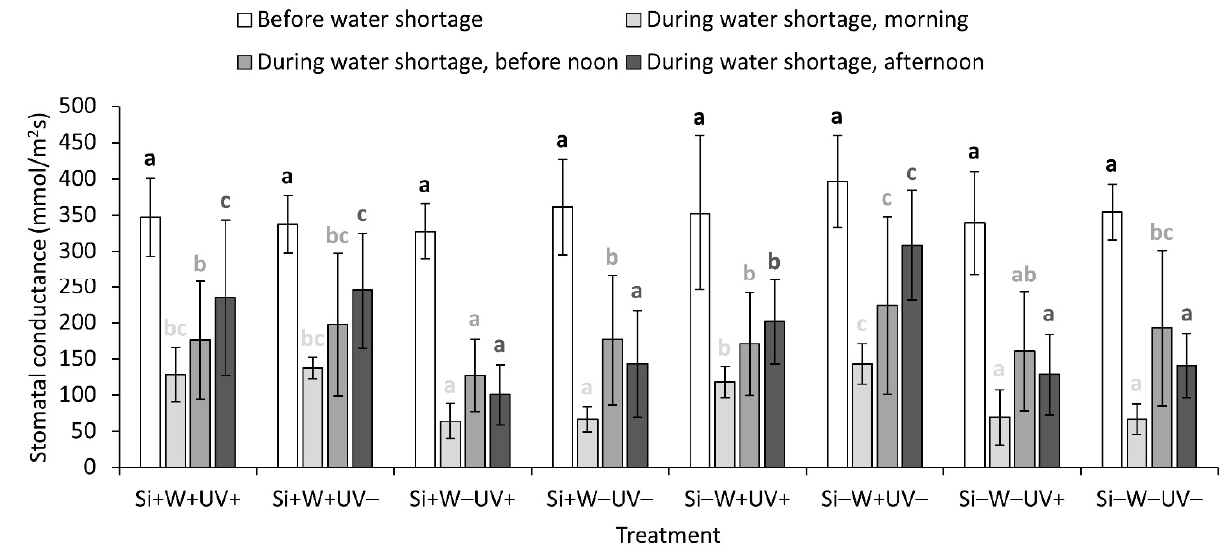
Figure 2. Stomatal conductance before water shortage and during water shortage in the morning ( n = 10) and before noon and in the afternoon ( n = 15) for cucumber plants grown under the eight different treatments. Different letters indicate significant differences between the treatments for each of the four parameters separately.